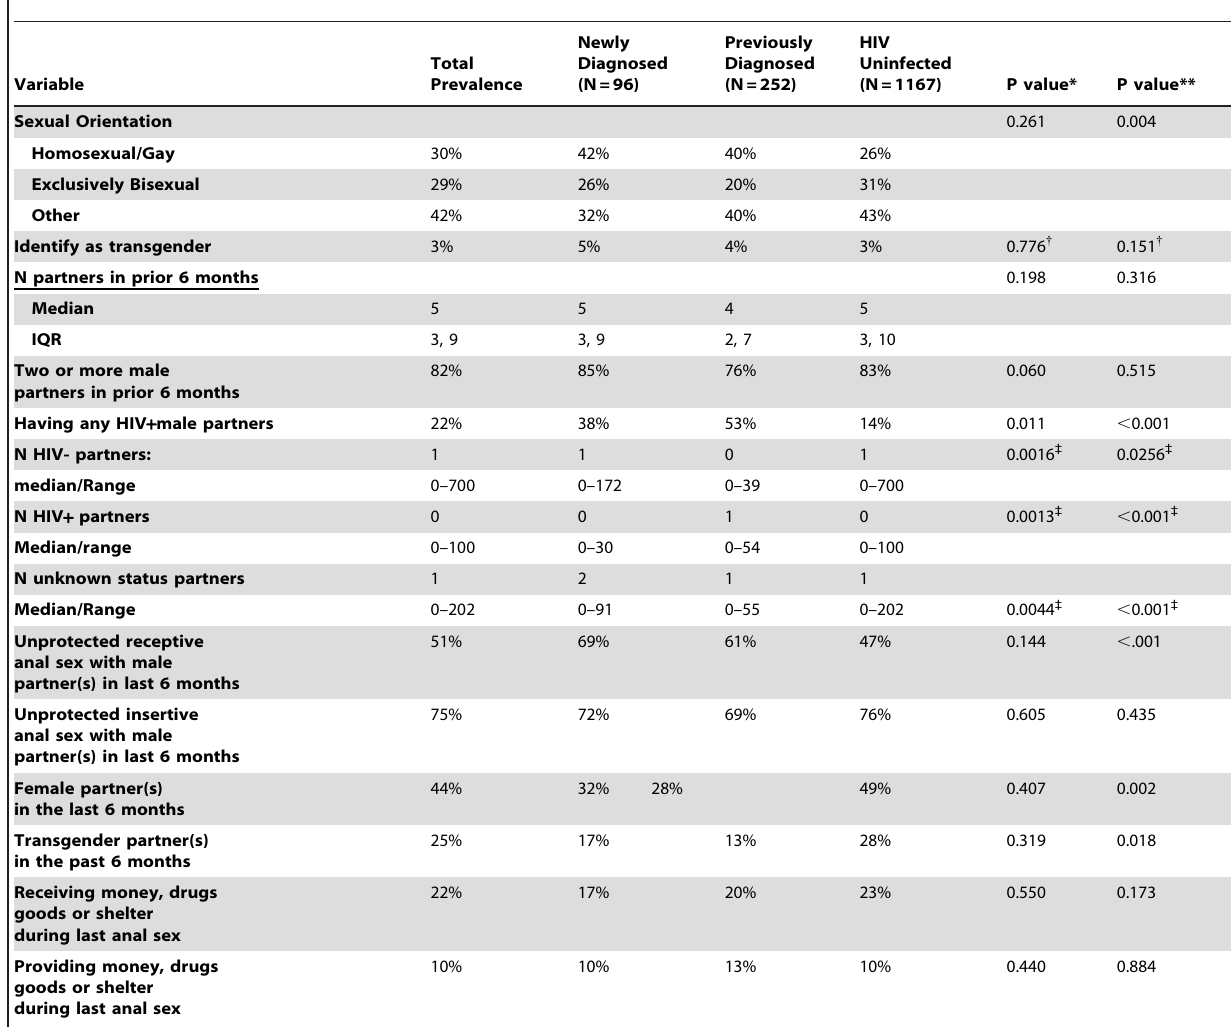
Table 2. Sexual identity and behavior of HPTN 061study participants by HIV status: Newly diagnosed versus previously diagnosed or